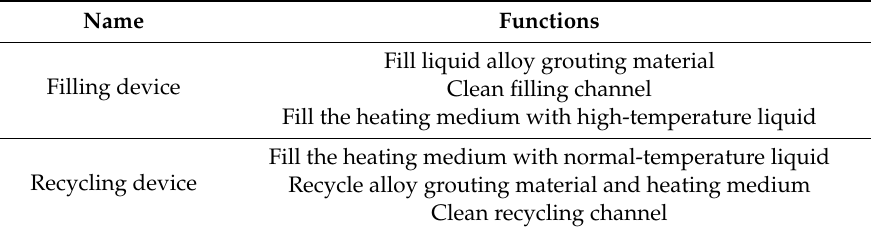
Table 2. Filling device and recycling device